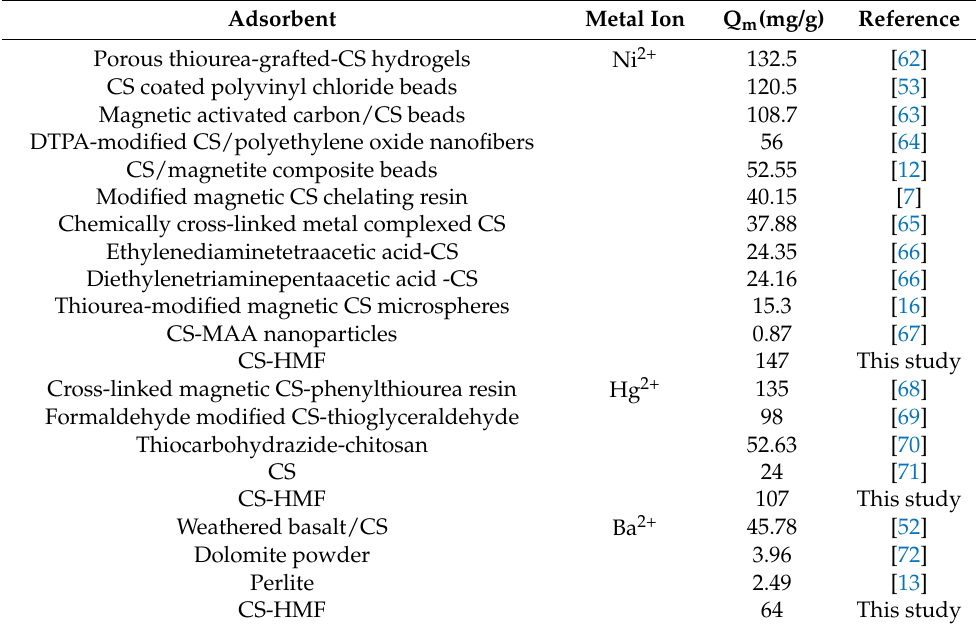
Table 7. Comparative study for the uptake of Ni 2+ , Hg 2+ , and Ba 2+ , from single-component aqueous solutions, using various adsorbents (mainly CS). Below are presented the adsorption capacities according to the Langmuir model (T = 25 ◦